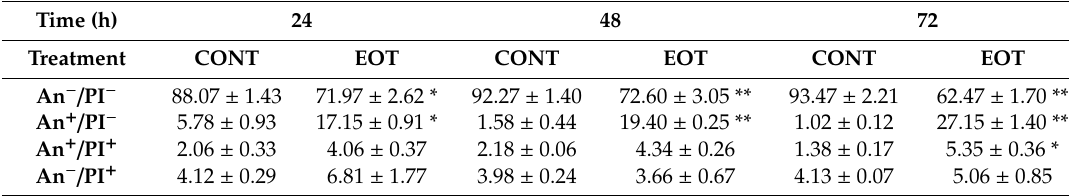
Table 6. Induction of apoptosis in MDA-MB-231 cells after EOT